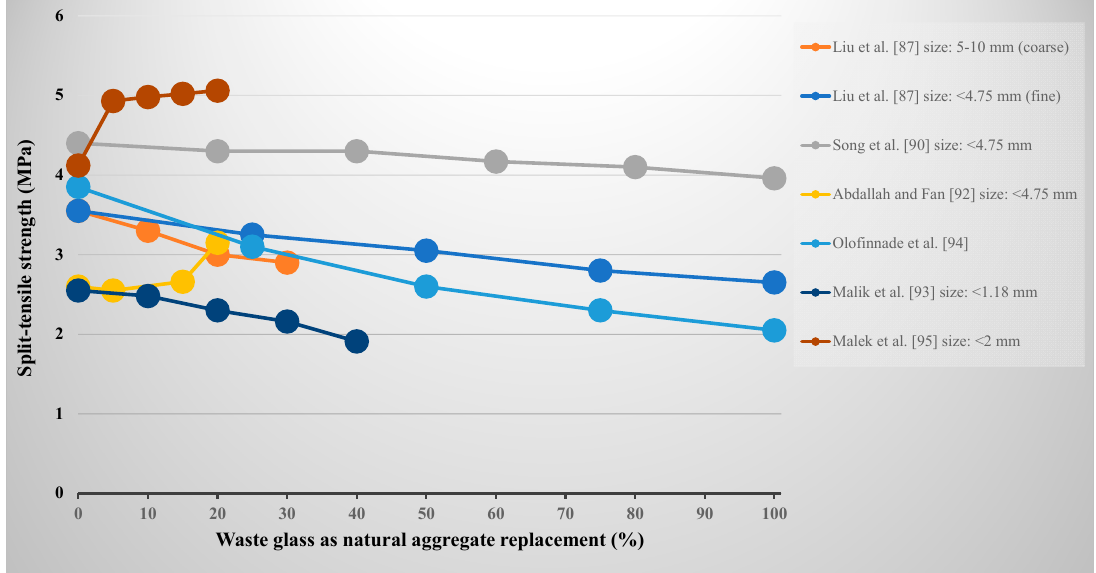
Figure 11. Effect of waste glass as a natural aggregate replacement on 28-days split-tensile